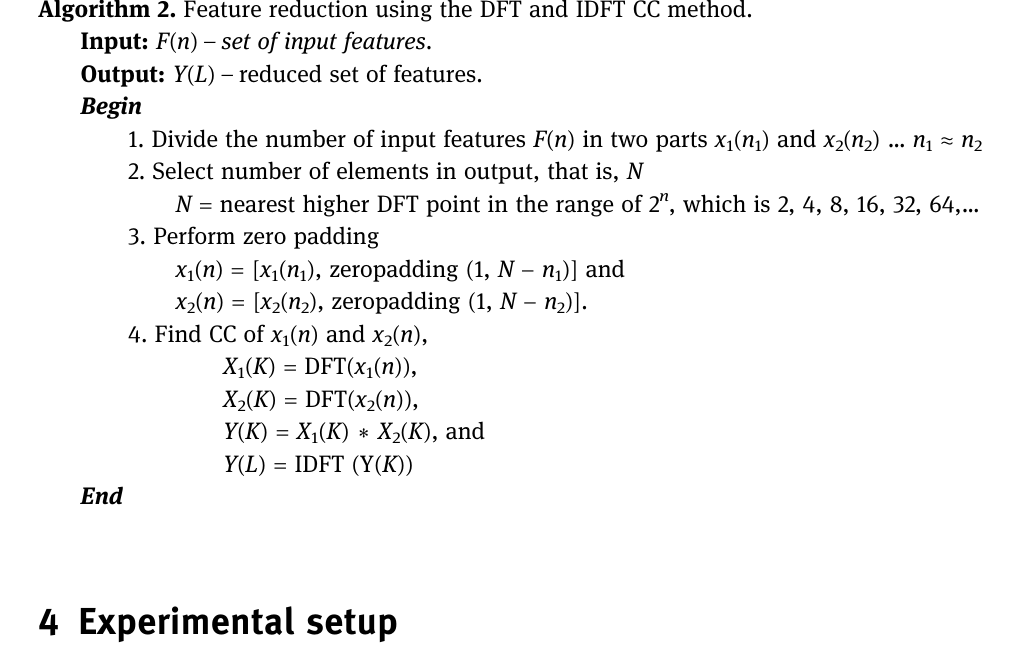
Algorithm 2. Feature reduction using the DFT and IDFT CC